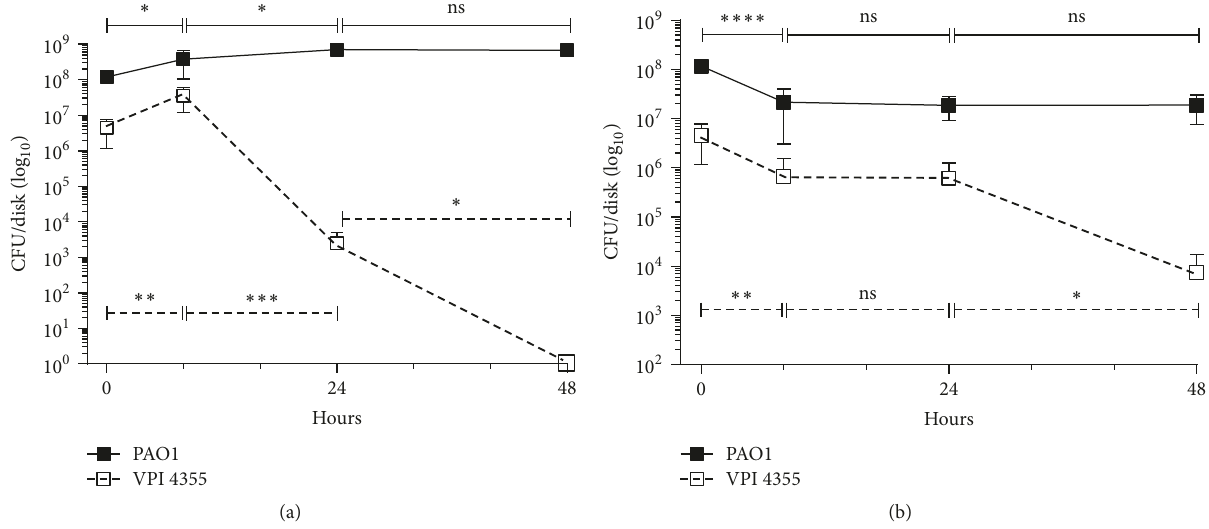
Figure 7: Growth of F. nucleatum within the P. aeruginosa/F. nucleatum biofilm depends on the environment around the biofilm. PAO1 and VPI 4355 were inoculated into two sets of tubes of BHI broth containing cellulose disks as described in Figure 2 and incubated aerobically for 24 h at 37 ∘ C. (a) Disks were removed from one set of tubes, placed on the surface of BHI agar plates, and incubated aerobically for 48 h at 37 ∘ C. At intervals indicated on the graph, the disks were removed from the plates and the number of CFU/disk was determined. (b) Disks from the second set of tubes were transferred to fresh tubes of BHI broth and incubated aerobically for 48h at 37 ∘ C. At intervals indicated on the graph, the disks were removed from the broth and the number of CFU/disk was determined. Values in (a) and (b) represent the means of three independent experiments ± SEM; ∗ 𝑃 < 0.05 ; ∗∗ 𝑃 < 0.01 ; ∗∗∗ 𝑃 < 0.001 ; ∗∗∗∗ 𝑃 < 0.0001 ; ns, no significant